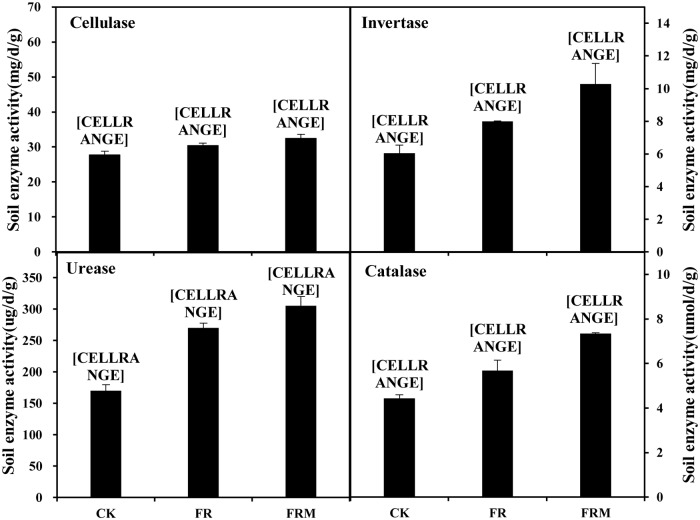
Compost and inorganic fertilizer effects on cellulase, invertase, urease and catalase activities in soil.Vertical bars denote the standard error of the mean (n = 3). Different letters a, b and c indicate significant differences between treatments at P < 0.05.